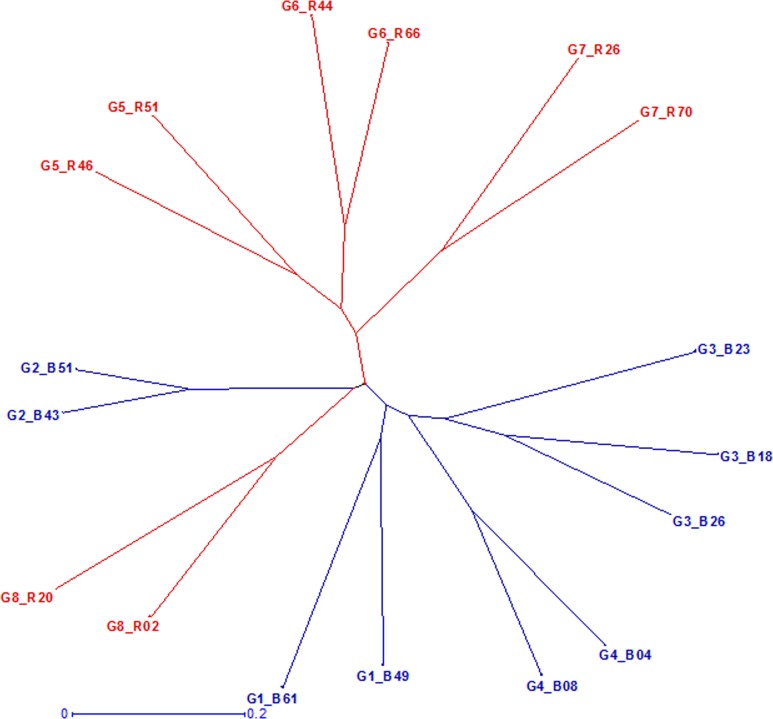
Clustering pattern of selected representative set of 17 hybrid parents using SSRs from the 8 marker based groups (mentioned from G1 to G8).